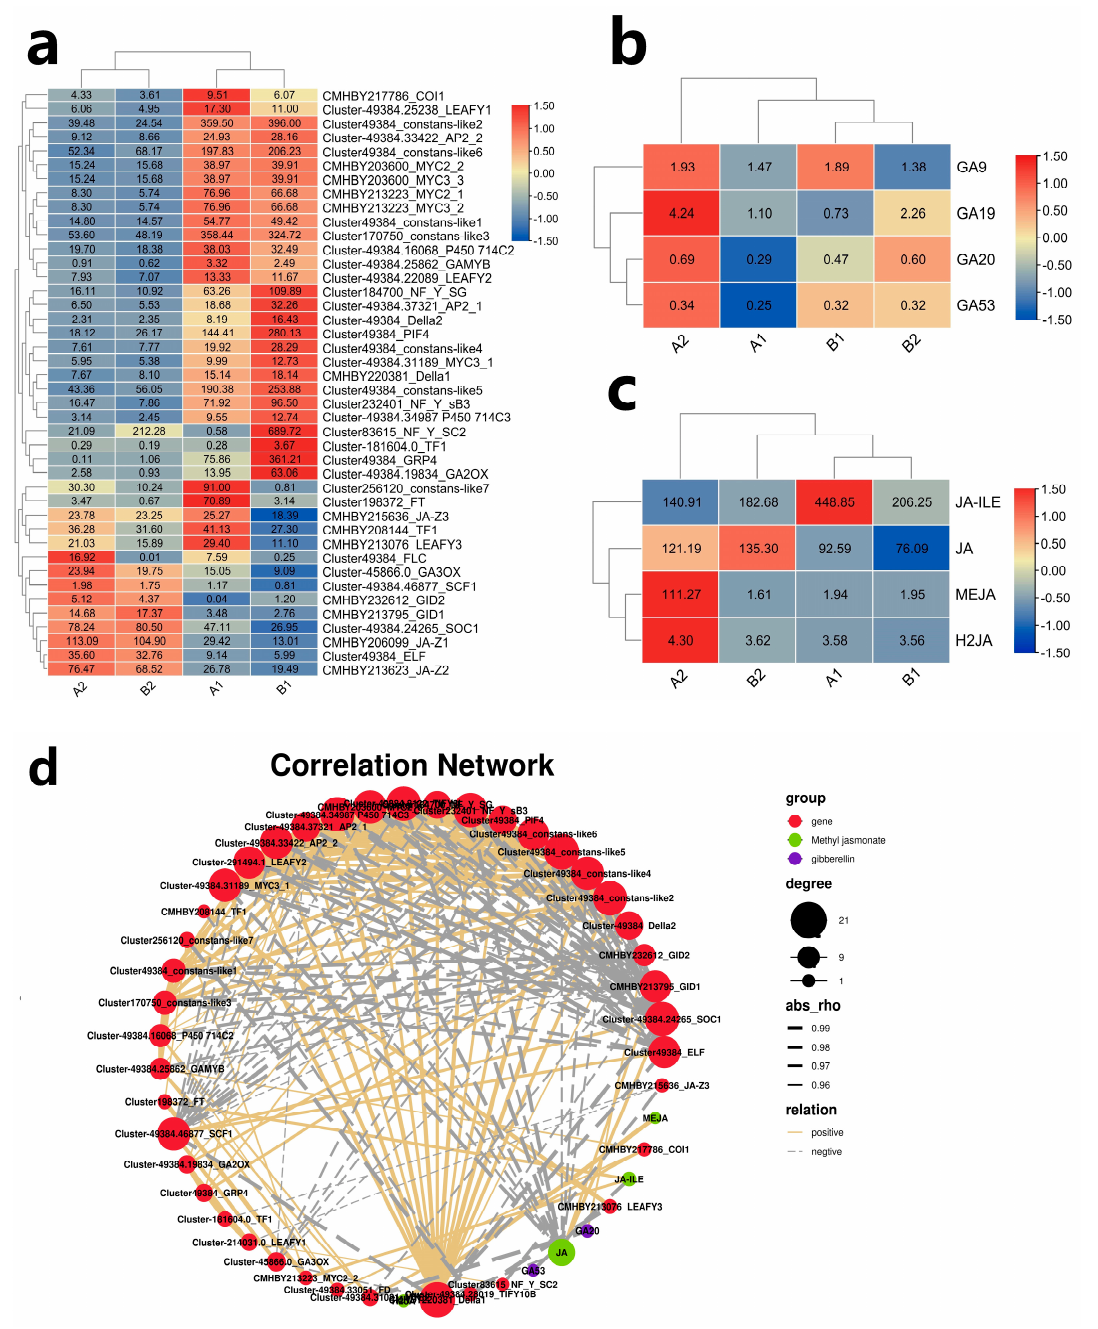
Figure 9. Changes of phytohormones content and expression of related genes in two different mixed flower buds of C. mollissima . A1. The CMF in post-winter; B1: The IMF in post-winter; A2: The CMF in pre-winter; B2: The IMF in pre-winter. ( a ) Analysis on the expression of flower bud differentiation related genes in complete mixed flower buds and incomplete mixed flower buds of chestnut at different stages; ( b ) The GAs content of two mixed flower buds in pre- and post-winter; ( c ) Difference analysis of MeJA content in different flower buds at different stages; ( d ) Regulating network between the selected genes and phytohormones compounds in chestnut flowering bud. The positive correlation threshold is set to be greater than or equal to 0.5, the negative correlation threshold is set to be less than or equal to − 0.5, and the p -value threshold is less than 0.5, R version 3.6.1,